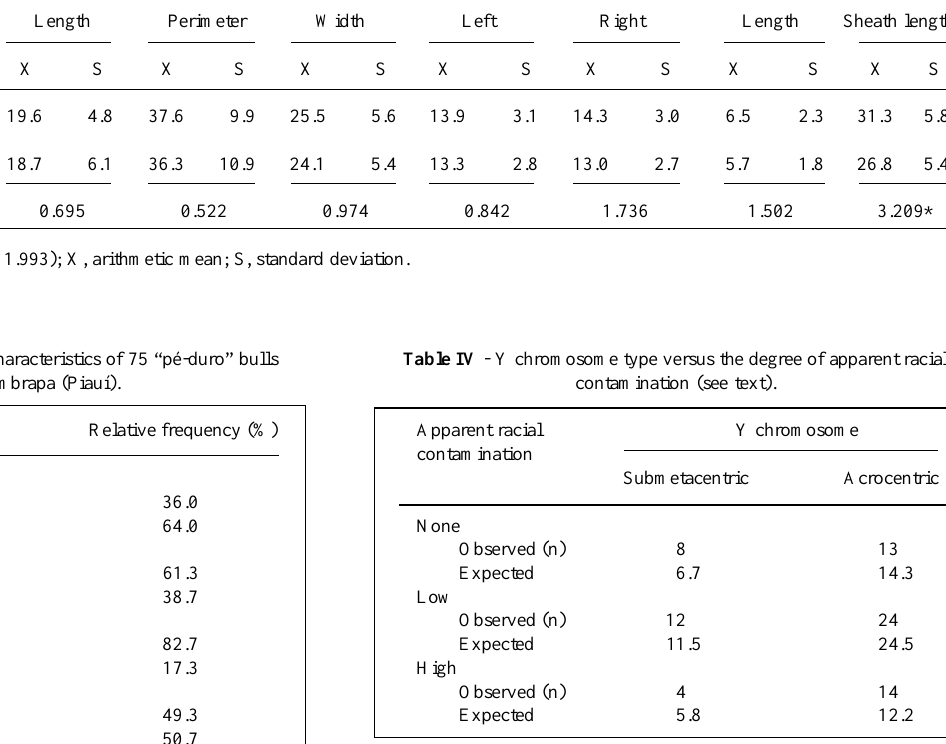
Table II - Morphometric data (in cm) for elements of the outer genitalia of “pé-duro” bulls with different Y chromosome types. Y chromosome No. of Scrotum Testis width Prepuce animals Length Perimeter Width Left Right Length Sheath length X Acrocentric